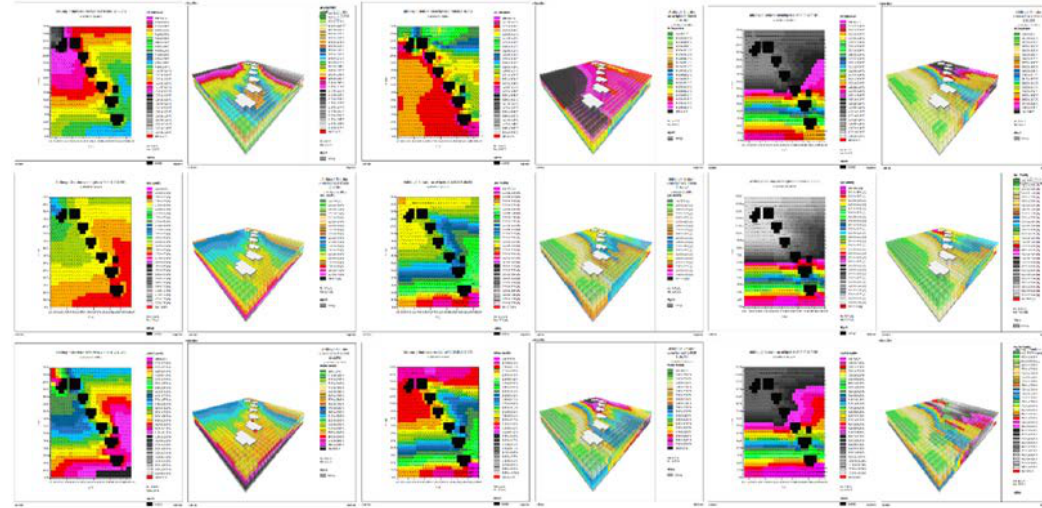
Fig. 7: 3D thermal model and map, specific humidity and relative humidity resulting from simulation of the hottest, coldest and sultry day of the year for high-rise type